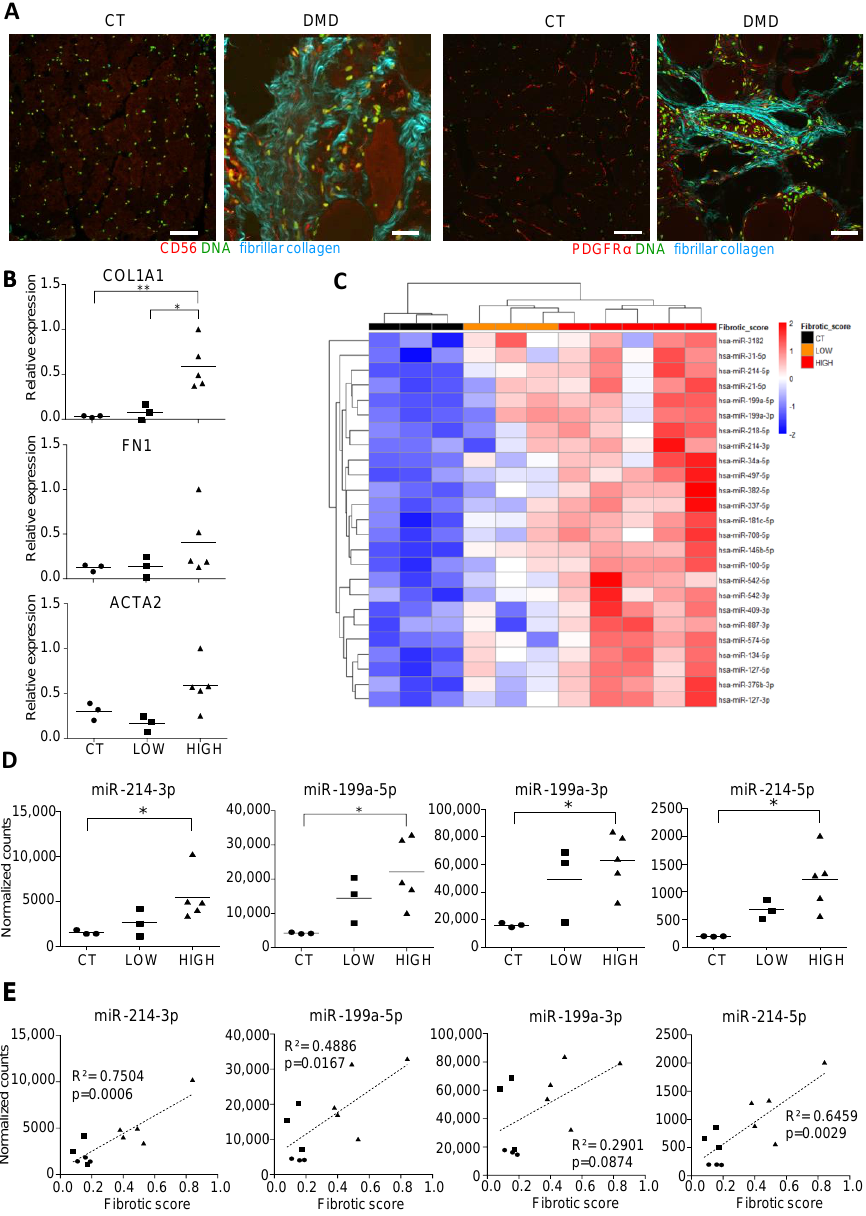
Figure 1. miRNA expression in DMD versus control muscle biopsies. ( A ) Intramuscular fibrillar collagen was visualized in cyan by second-harmonic generation imaging on cryostat sections from one healthy (CT) or DMD donor. Sections